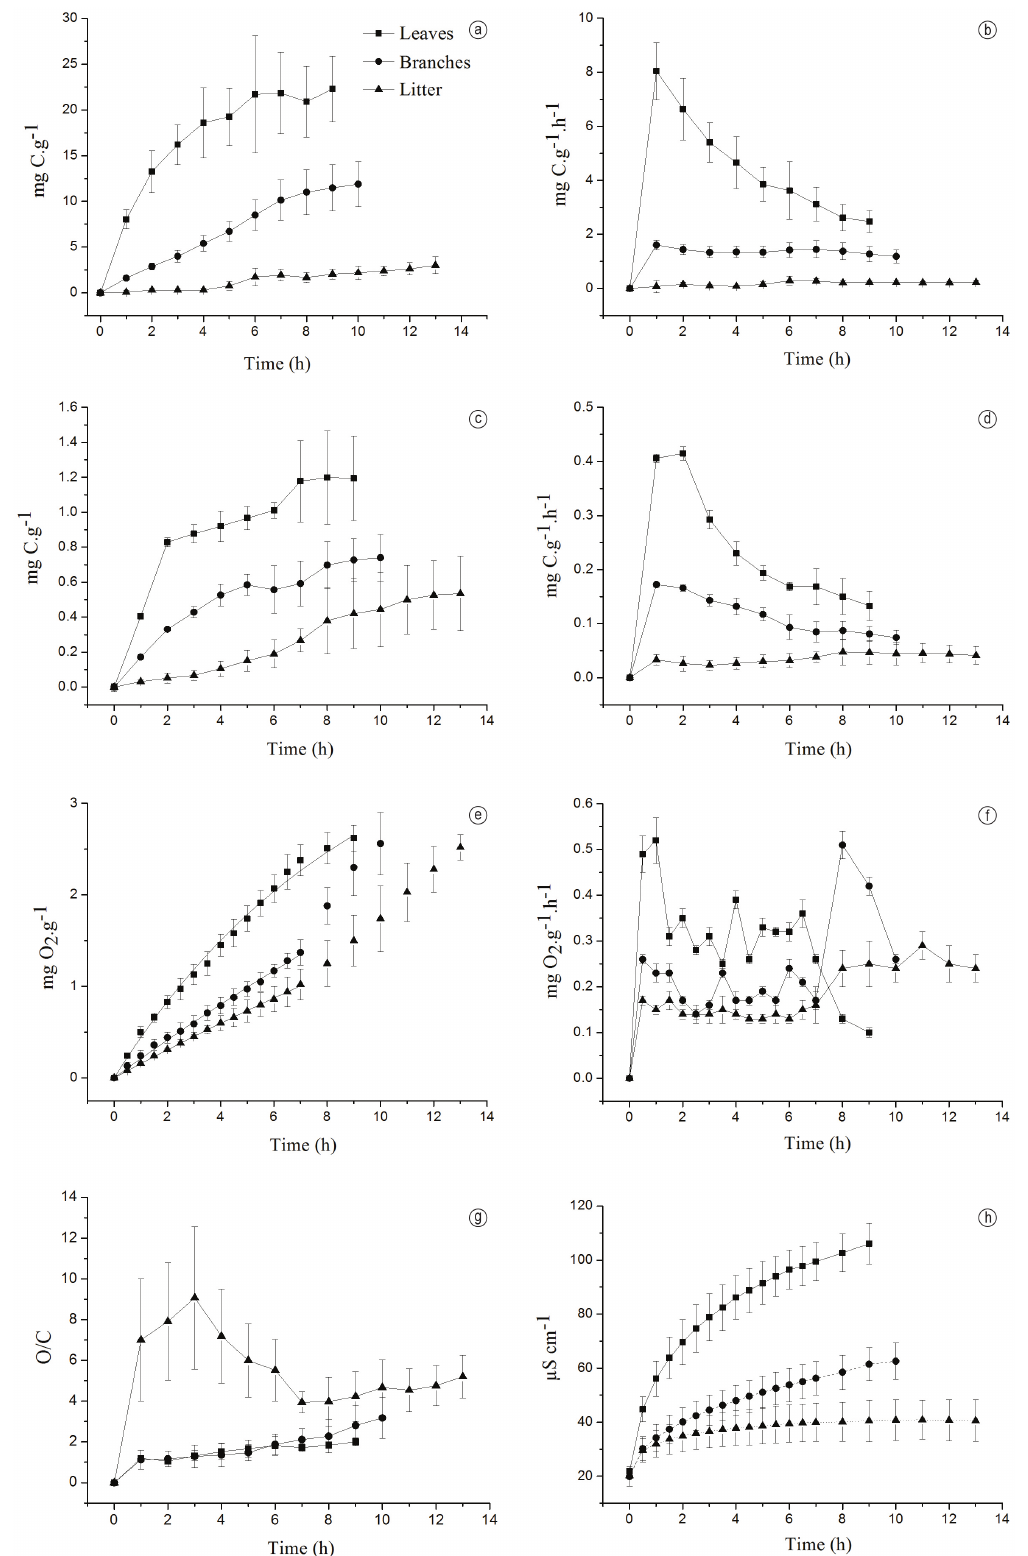
Figure 1. Temporal variation (a) and the hourly rates (b) of DOC release, temporal variation (c) and the hourly rates (d) of DIC production, kinetic fittings (e) and the hourly rates (f) of O stoichiometry (O/C ratio) (g) and electrical conductivity (h) from aerobic mineralization of leaves, branches and litter. [n = 3, bars = standard